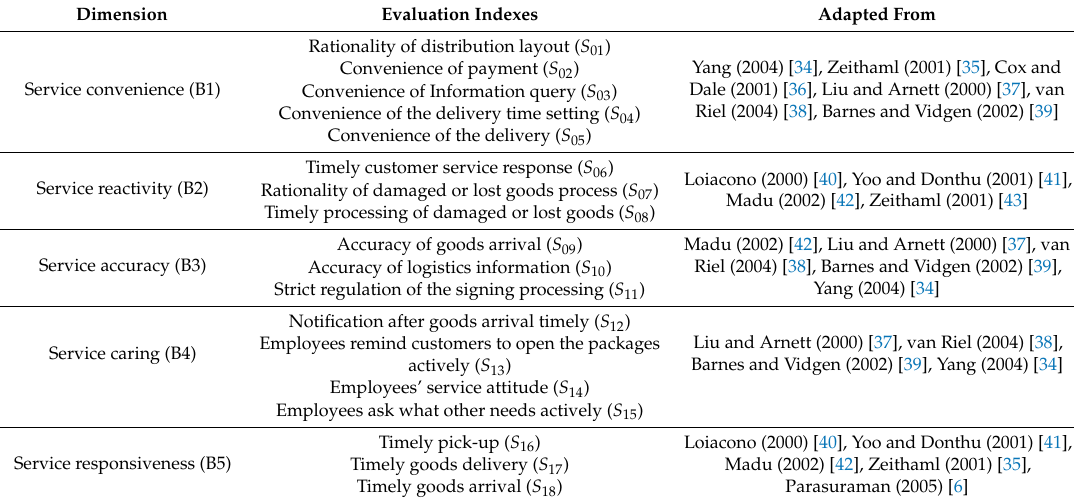
Table 1. Service quality evaluation indexes of the rural last mile